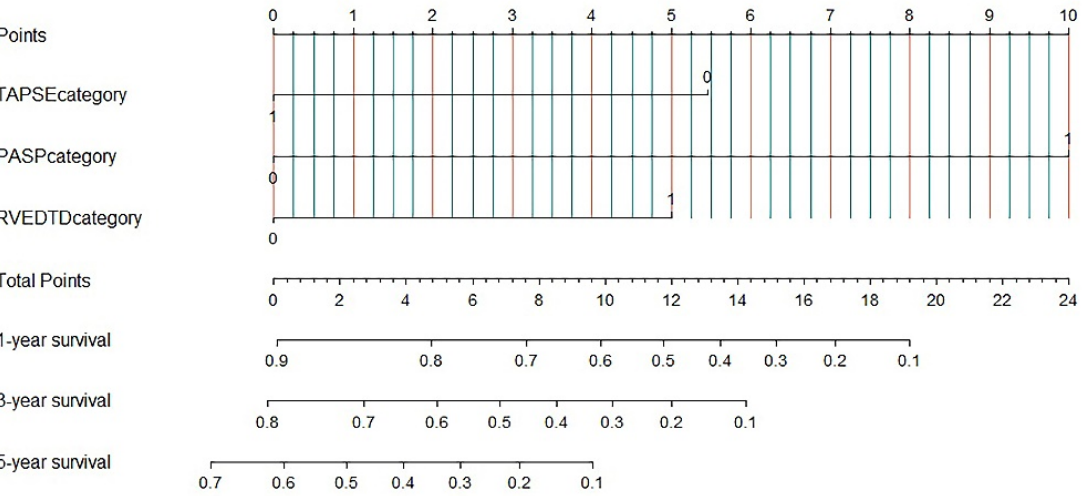
Figure 5. Nomogram for predicting all-cause mortality in severe CLD-PH. PASP: pulmonary arterial systolic pressure; RVEDTD: right ventricular end-diastolic transverse dimension; TAPSE: tricuspid annular plane systolic excursion.